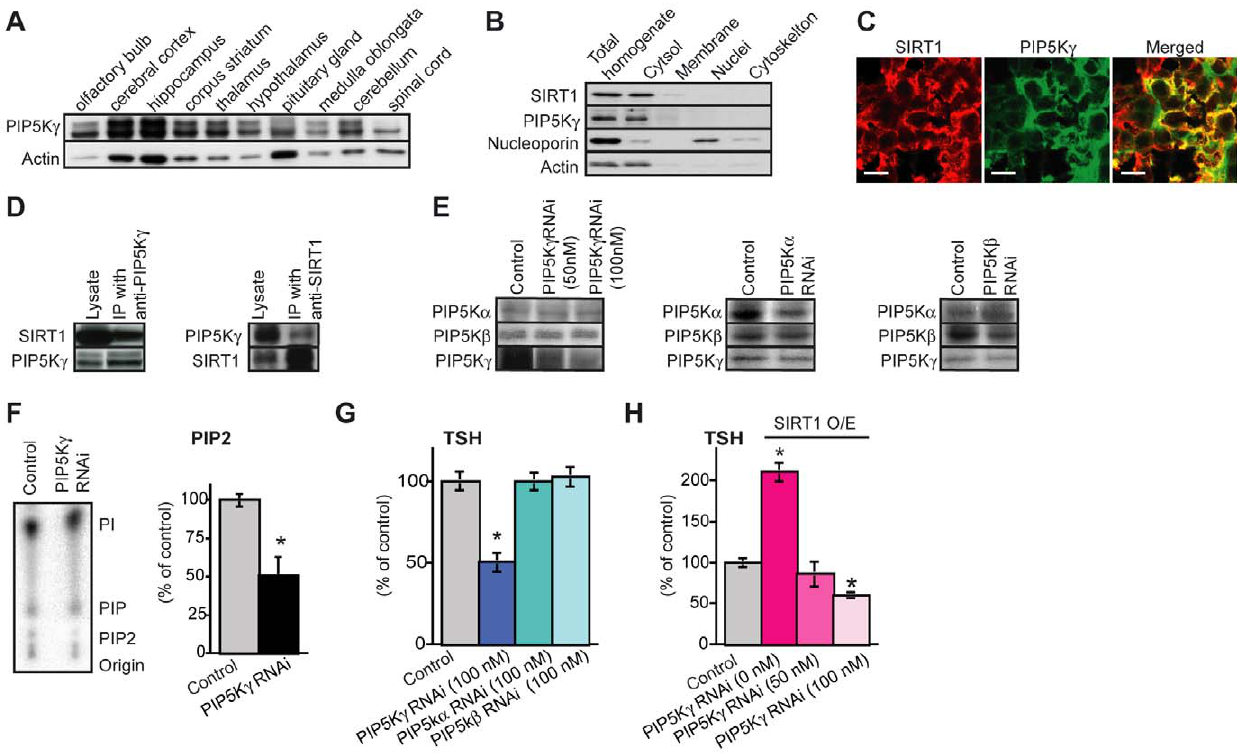
Figure 5. SIRT1 regulates TSH secretion via PIP5K c (K265/K268). (A) Western blot analysis of PIP5K c in the nerve tissues of mice. (B) Distribution of SIRT1 and PIP5K c in fractionated pituitary gland of mice. SIRT1 and PIP5K c were found to be present in cytosolic fractions rather than nuclear fractions. The first lane contains crude extract prior to separation. Nucleoporin, a nuclear marker; actin, a cytosolic fraction marker. (C) Double immunostaining with SIRT1 (red) and PIP5K c (green) in the anterior pituitary gland of rats. Scale bar, 10 mm. (D) Co-immunoprecipitation analysis of SIRT1 and PIP5K c in the cytosolic fraction of the pituitary gland of mice. Rabbit IgG was used as the negative control. (E) Western blot analysis of each PIP5K in PIP5Ks RNAi knockdown cells. (F) TLC analysis of [ 32 P]PIP 2 was extracted from PIP5K c RNAi pituitary cells metabolically labelled (for 24 h) with [ 32 P]orthophosphate. The PIP 2 level was corrected for the PC level ( n =5). (G) Amounts of TSH secreted in each PIP5Ks RNAi knockdown cells ( n =16). (H) Amounts of TSH secreted in cells overexpressing SIRT1 and PIP5K c RNAi ( n =16). Empty vectors and random RNAi constructs were used as controls. Statistical analyses were performed using Fisher’s PLSD test. * P , 0.05 versus control. Values represent mean 6 SEM (% of control: F–H).